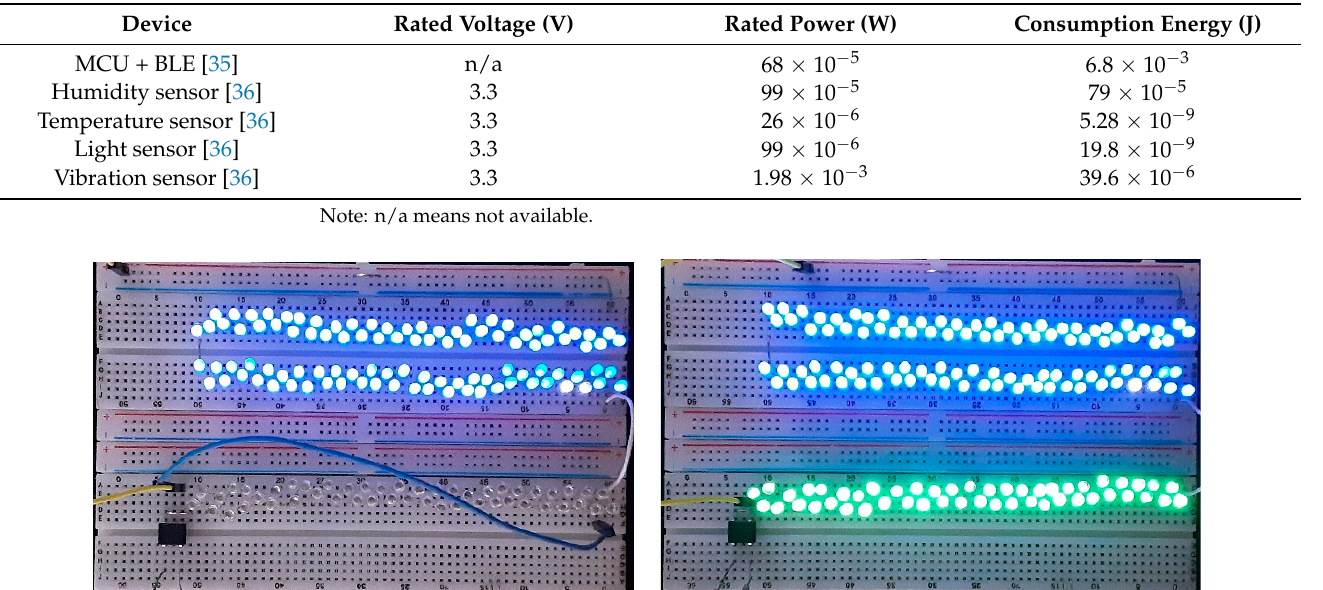
Table 2. List of small electronic devices that could be powered by the energy generated by TEHFT.